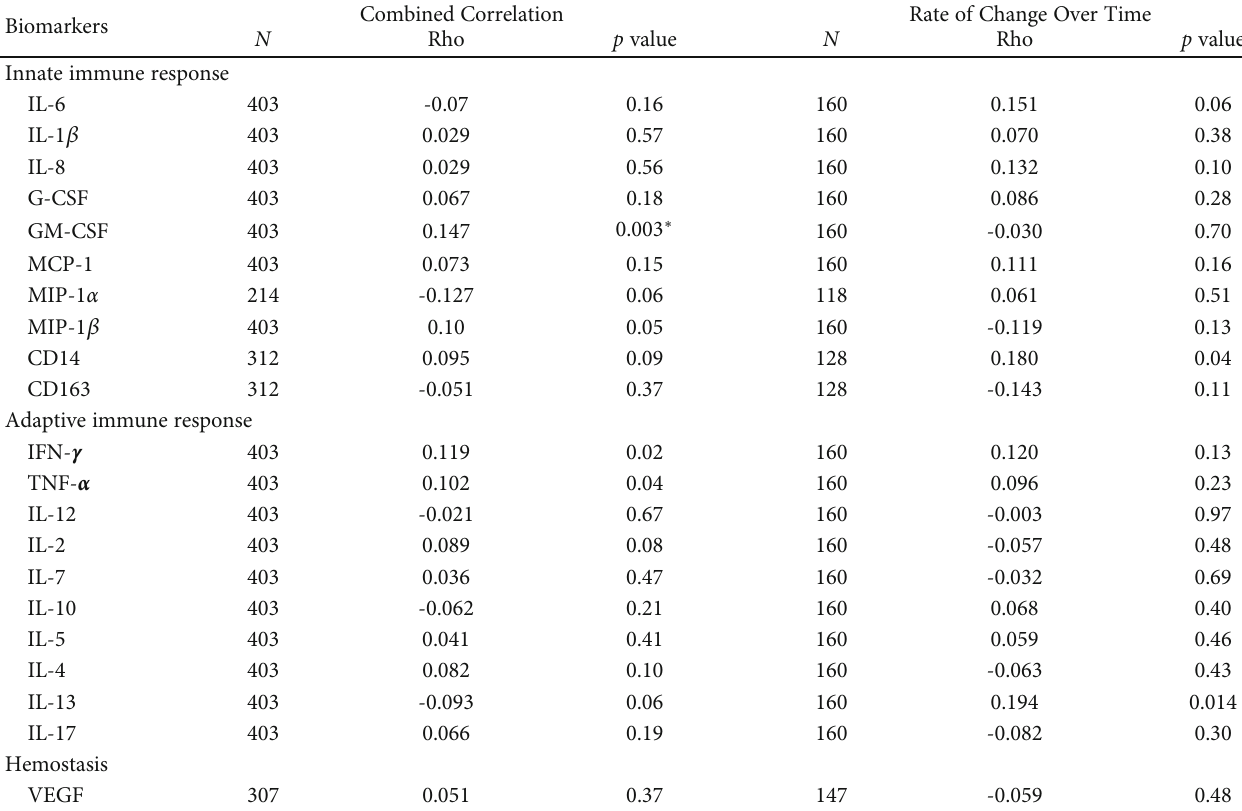
Figure 1: Scatterplot of interferon-gamma (IFN- γ ) and interleukin-4 (IL-4) at cryptococcal meningitis diagnosis in CSF versus serum. IFN- γ is a Th1 cytokine which is protective in cryptococcosis causing classical activation of macrophages to enhance killing of yeast. IL-4 is Th2 cytokine which is not protective in mouse models of cryptococcosis. Both cytokines have a weak, inverse correlation between levels observed in serum versus CSF. Levels are in pg/mL. Table 2: Correlation of CSF and serum cytokines pooled across all three time points at baseline, 1-week, and 2-week post cryptococcal meningitis